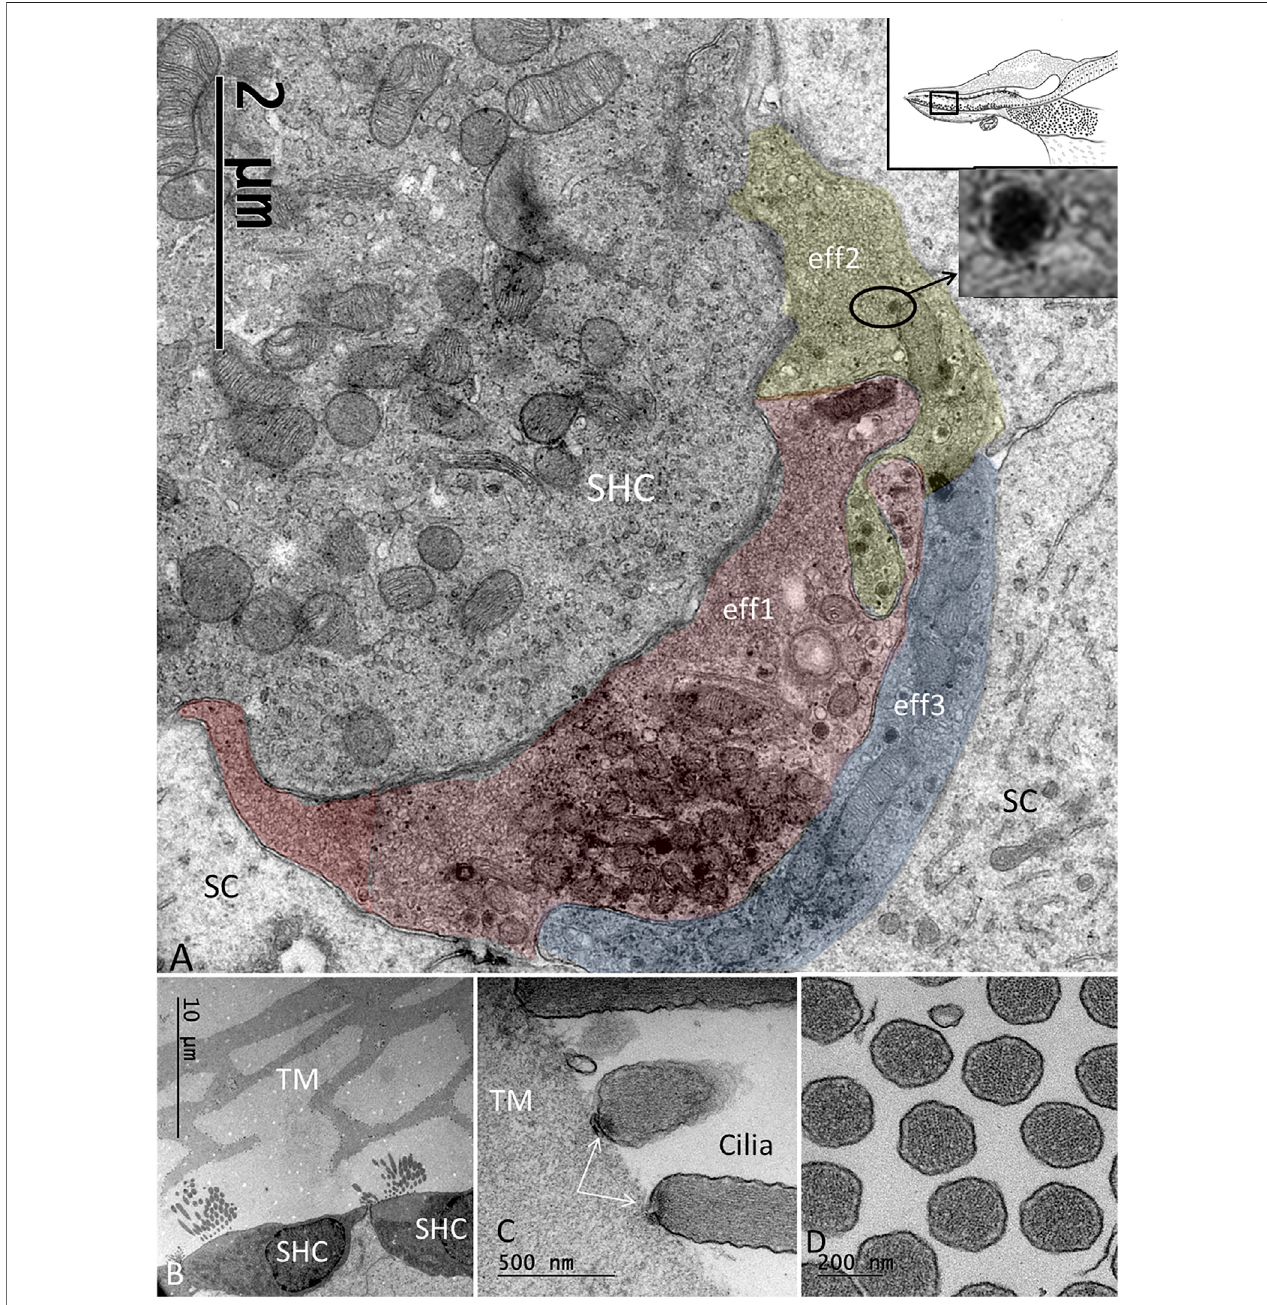
FIGURE 6 | (A) . Basal pole of an SHC connected to three efferent terminals (eff1, eff2, eff3). The boutons are fi lled with synaptic vesicles and abundant mitochondria. (B) .SHCsandassociatedTMhavingahoneycombstructure. (C) .TheciliarytipsoftheSHCsshowspecializationsatthecontactspointswiththeTM. (D) . Cross-sectioned stereocilia of an SHC show abundant actin fi laments.